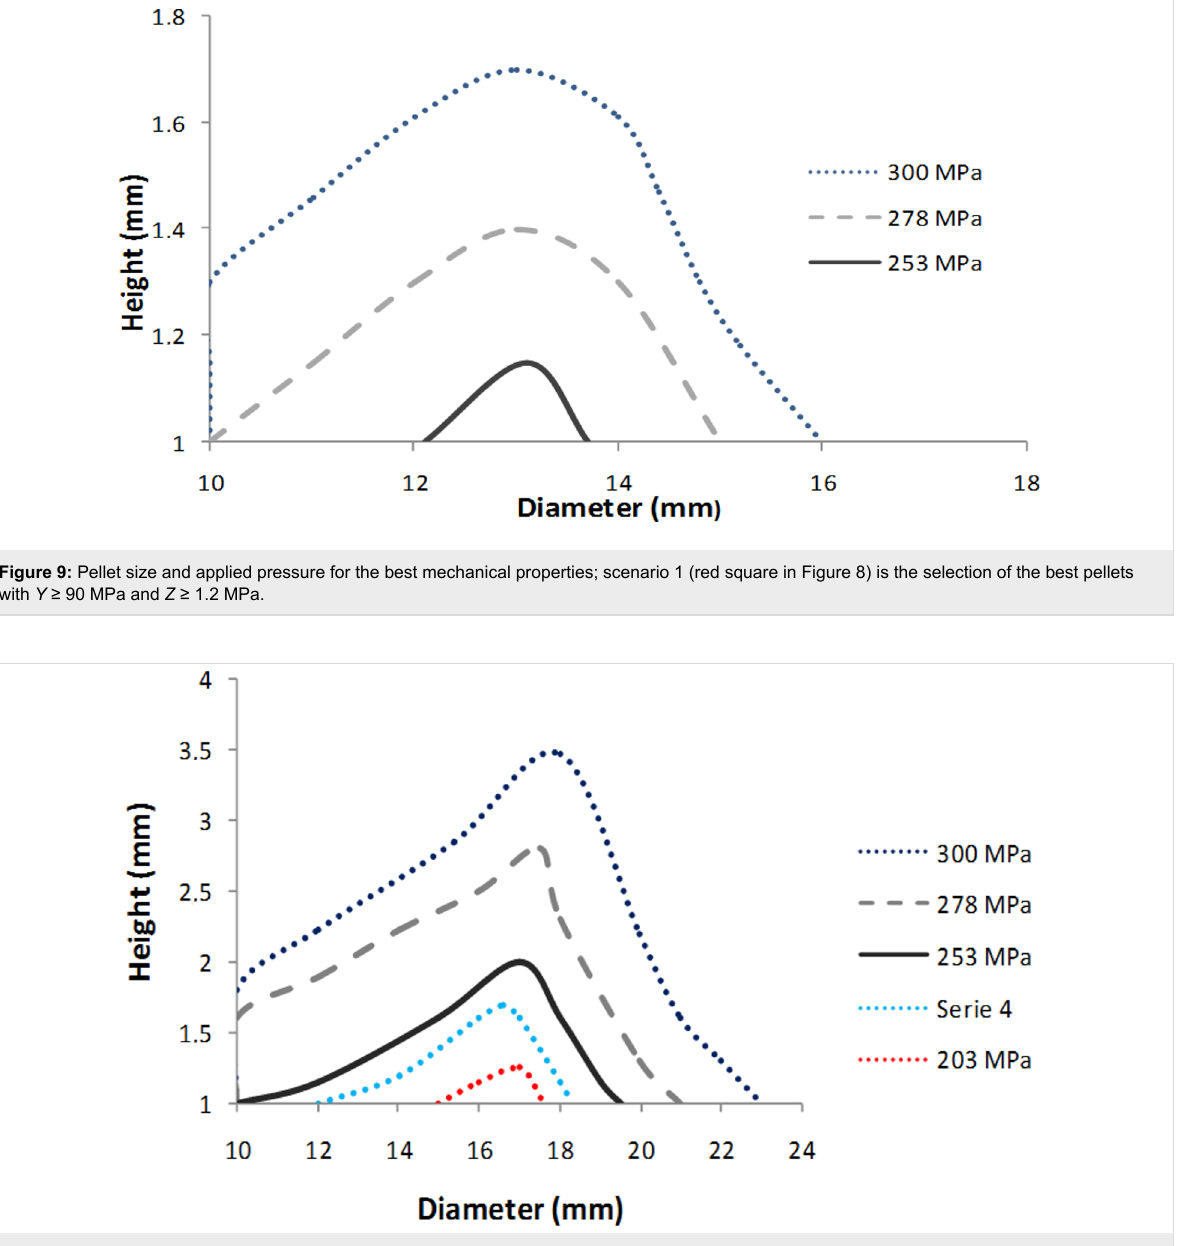
Figure 10: Pellet size and applied pressure for the best mechanical properties; scenario 2 (blue square in Figure 8) is the selection of the best pellets with Y ≥ 80 MPa and Z ≥ 0.8